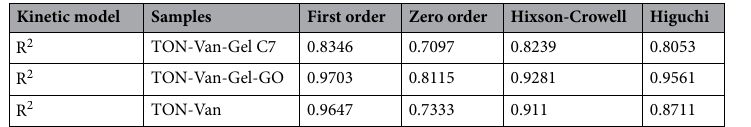
2 Table 6. R values of Vancomycin-delivery kinetics.